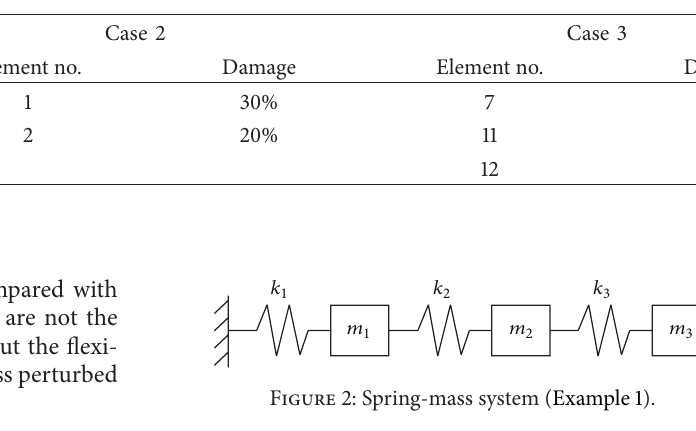
Table 2: Damage scenarios studied in [13] (Example 2).